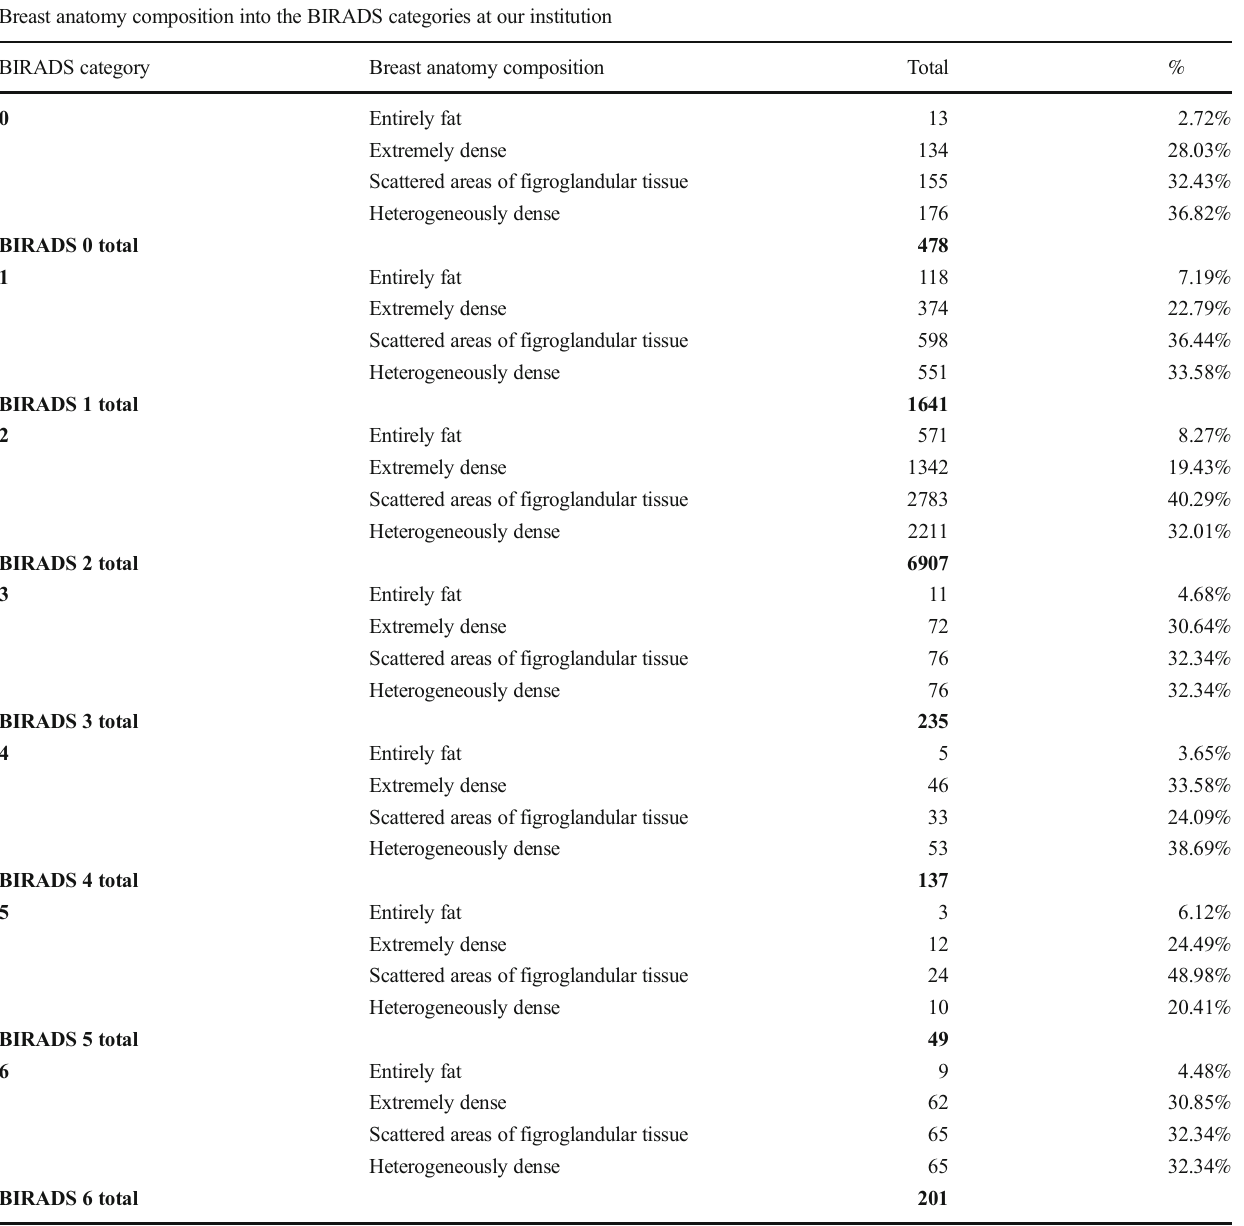
Breast anatomy composition distribution into the BIRADS categories during 2013 at our institution